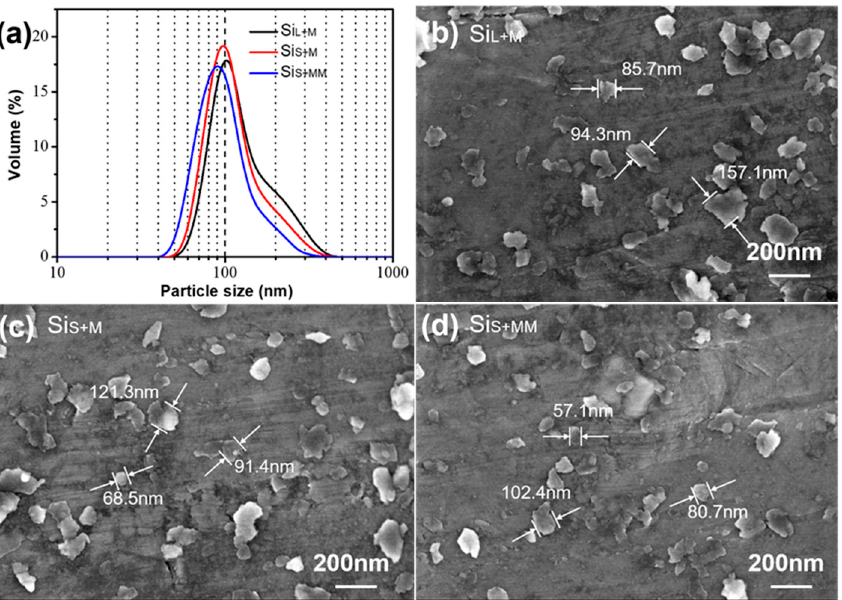
Figure 7. ( a ) Particle size distribution of Si L+M , Si S+M and Si S+MM , SEM images of ( b ) Si L+M , ( c ) Si S+M and ( d ) Si S+MM .